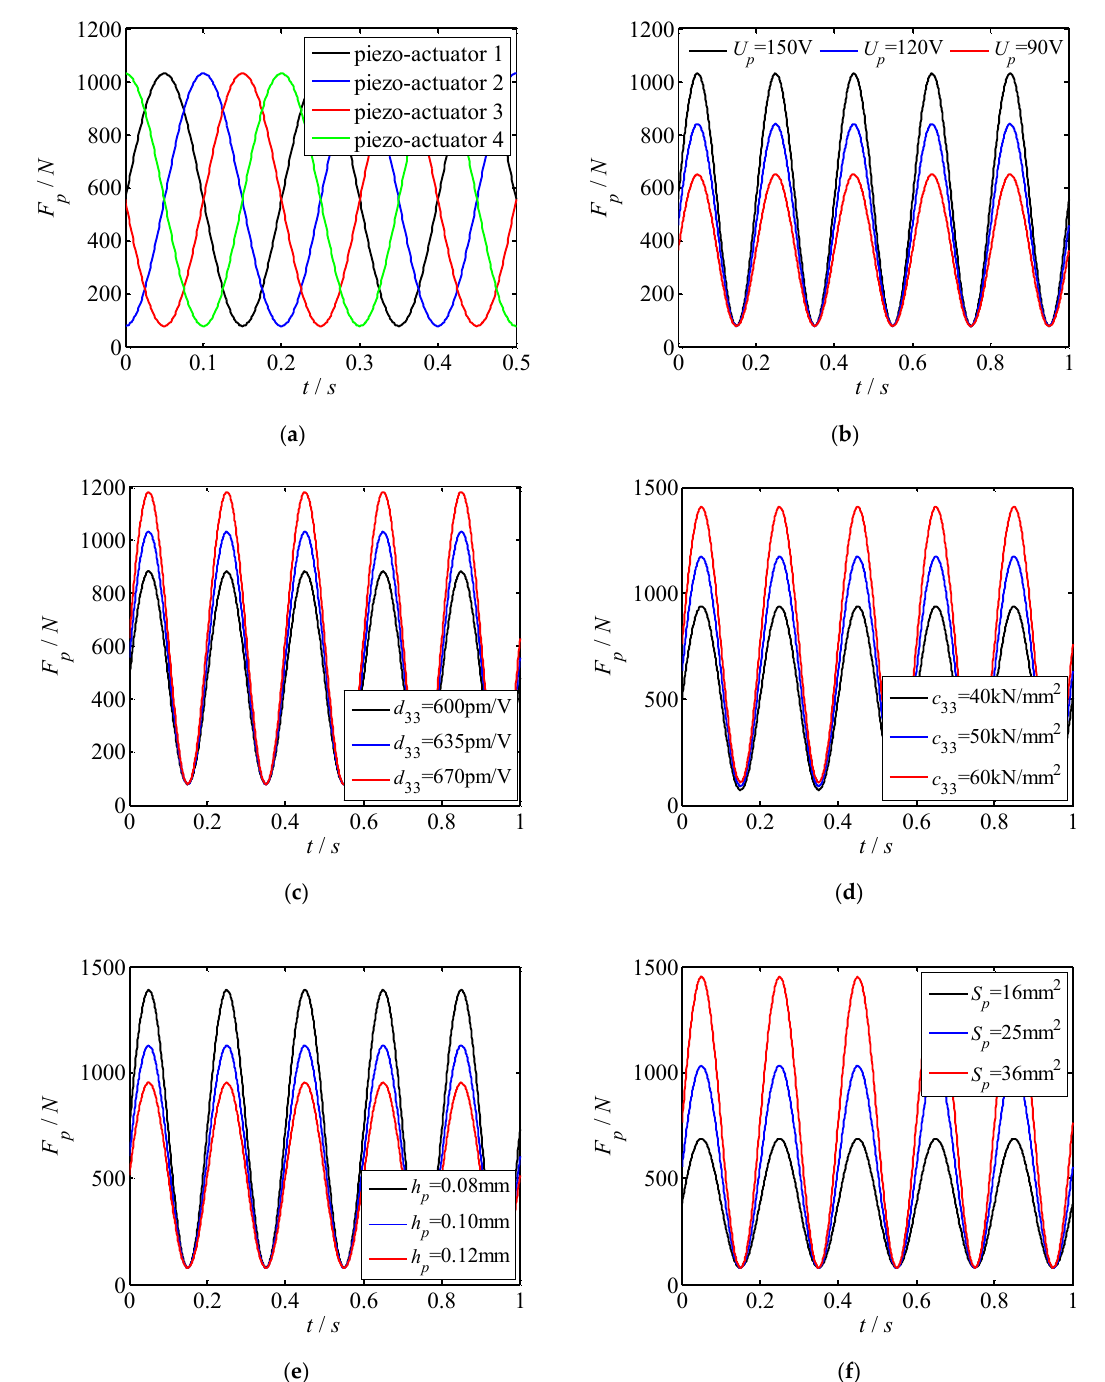
Figure 8. Output forces of the piezoelectric actuator. ( a ) Force changes with different piezo-actuator; ( b ) force changes with U p ; ( c ) force changes with d 33 ; ( d ) force changes with c 33 ; ( e ) force changes with h p ; ( f ) force changes with S p .